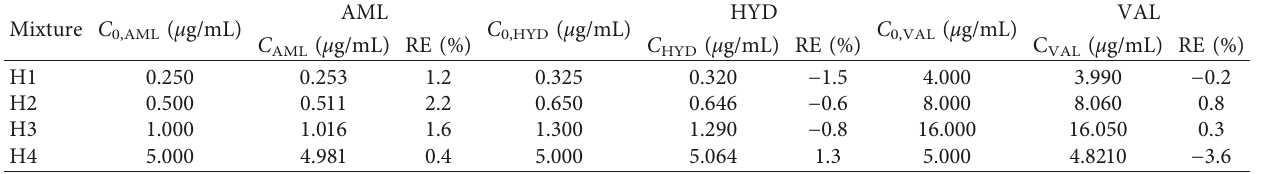
Table 5: Measured concentrations of AML, HYD, and VAL in the standard mixtures with corresponding RE values. Mixture C 0,AML ( µ g/mL)